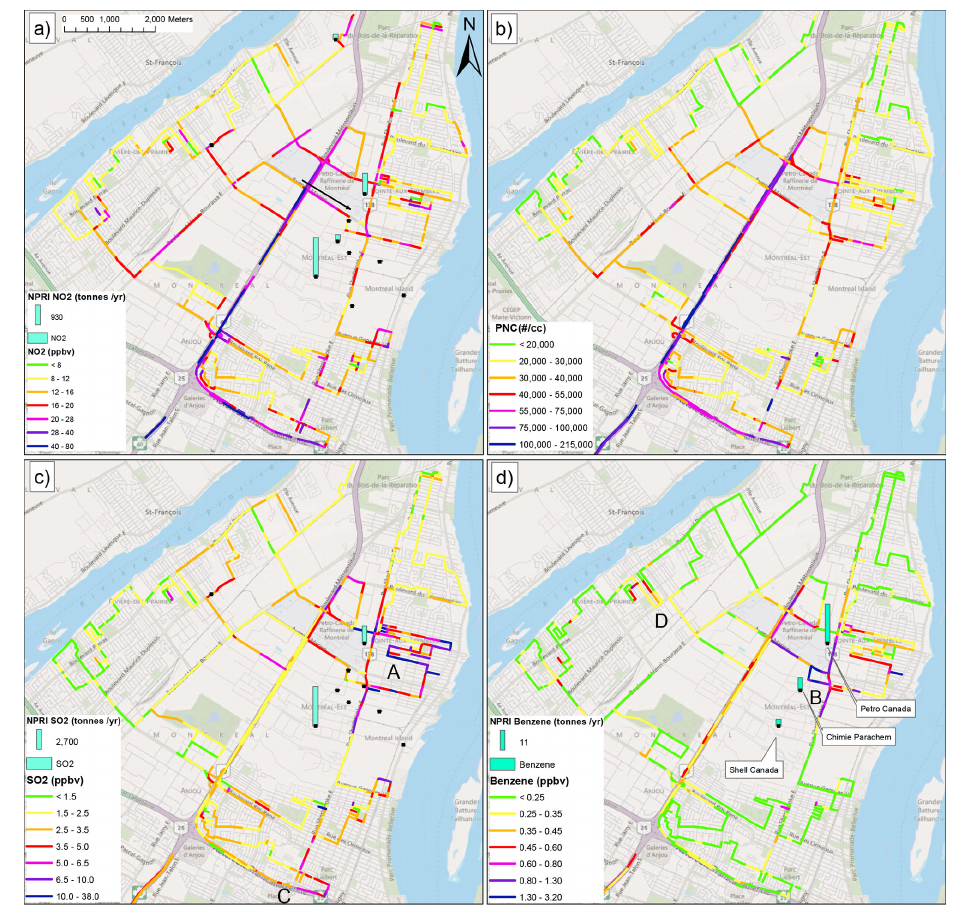
Figure 3. Mean pollution levels for the entire study at road segments for NO 2 (a) , PNC (b) , SO 2 (c) and benzene (d) , along with National Pollutant Release Inventory (NPRI) reported point emissions for the relevant pollutants. Roads were filtered as described in Sect. 2.4. NPRI emissions for NO 2 are nitrogen oxides expressed as NO 2